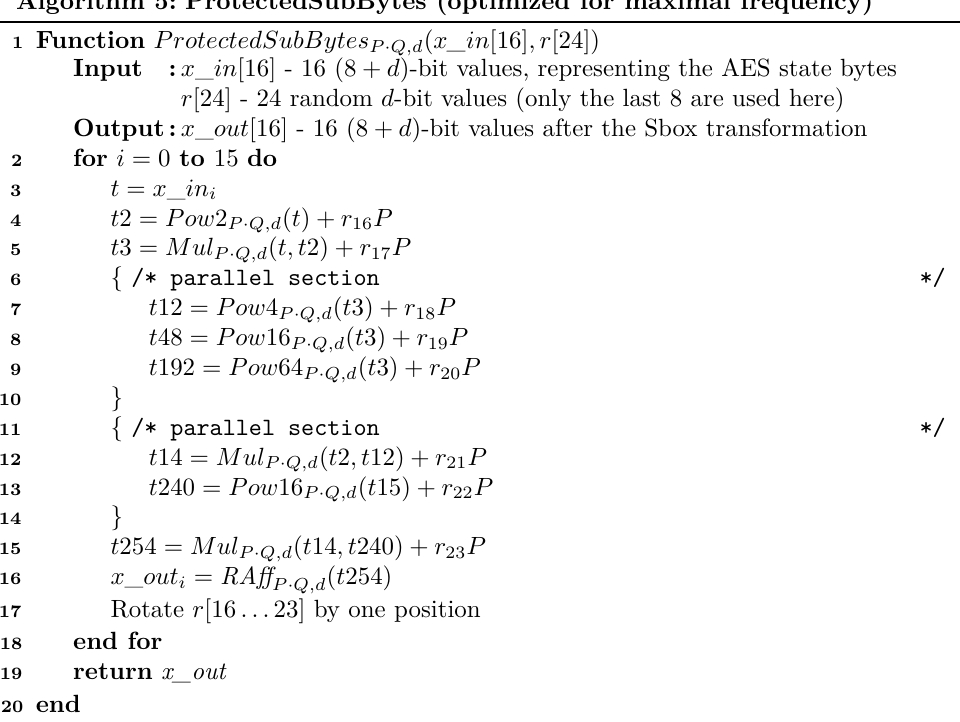
Algorithm 5: ProtectedSubBytes (optimized for maximal